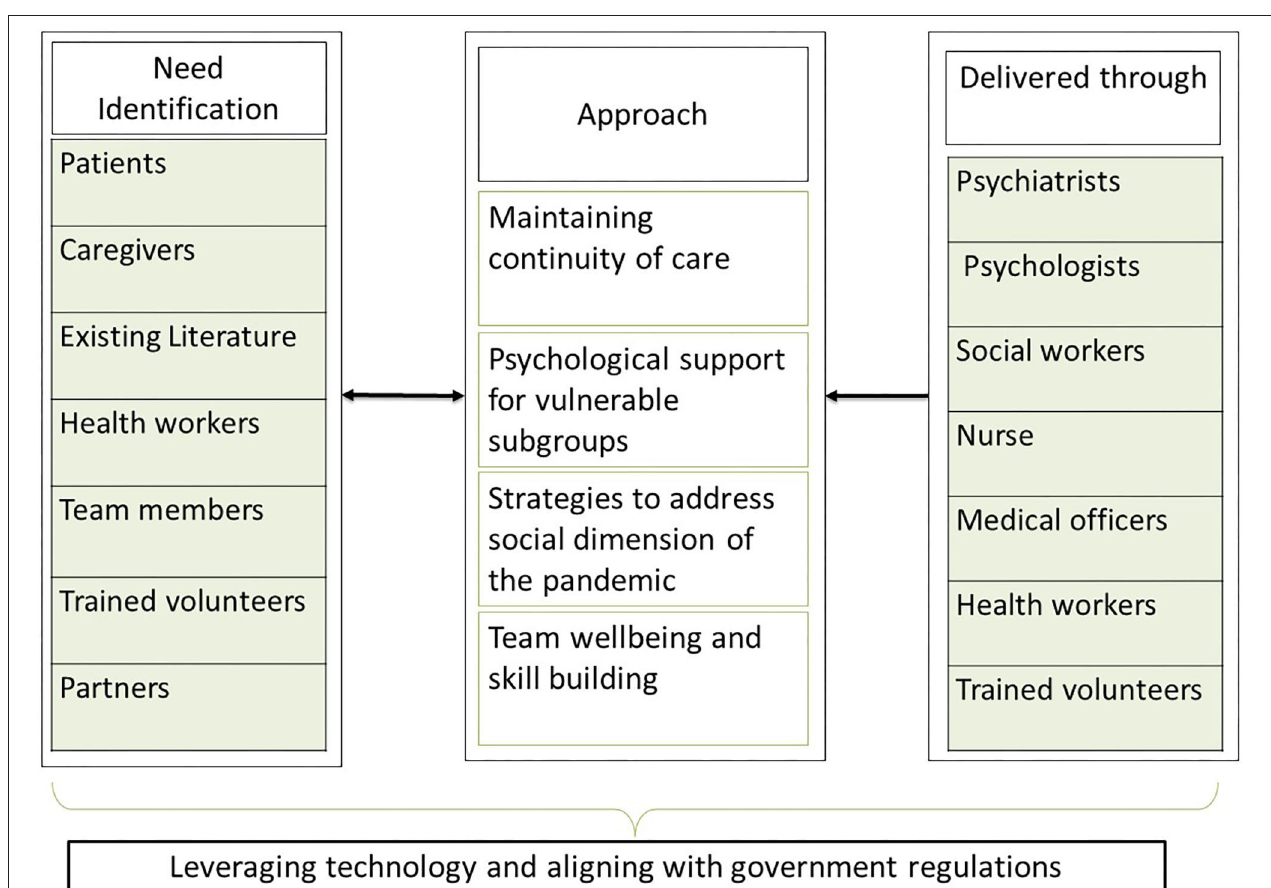
FIGURE 1 | Phases of need based Biopsychosocial response model implemented by Mehac, Kerala, India based on the COVID 19